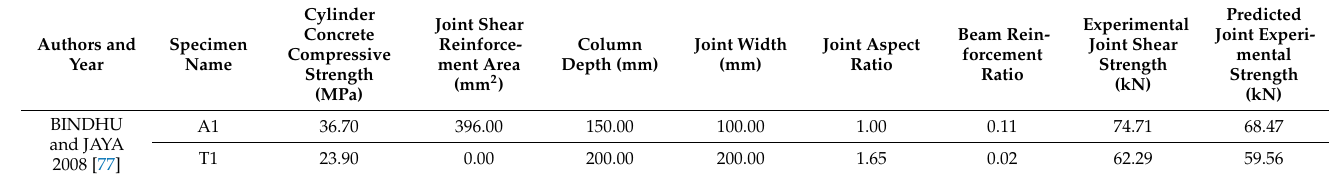
Table A2. Experimental Validation of Proposed